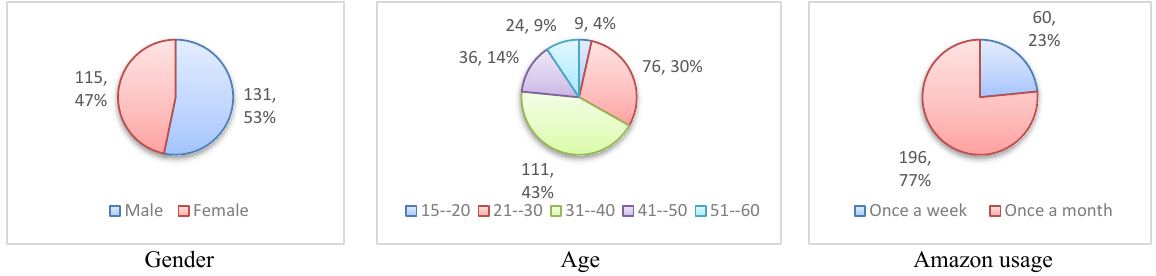
Fig. 2. Personal characteristics of the